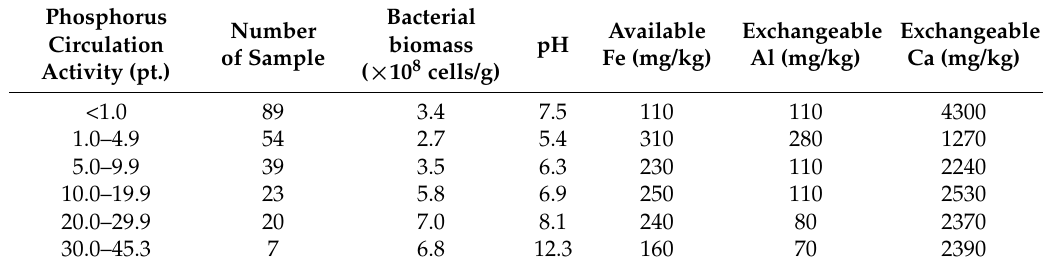
Table 1. Frequency distribution of samples with different levels of phosphorus circulation